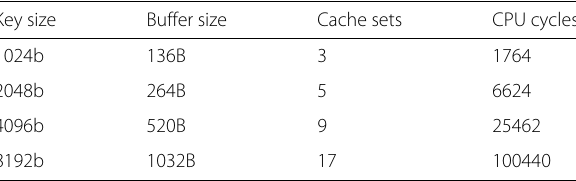
Table 3 RSA key sizes and the corresponding CPU cycles to